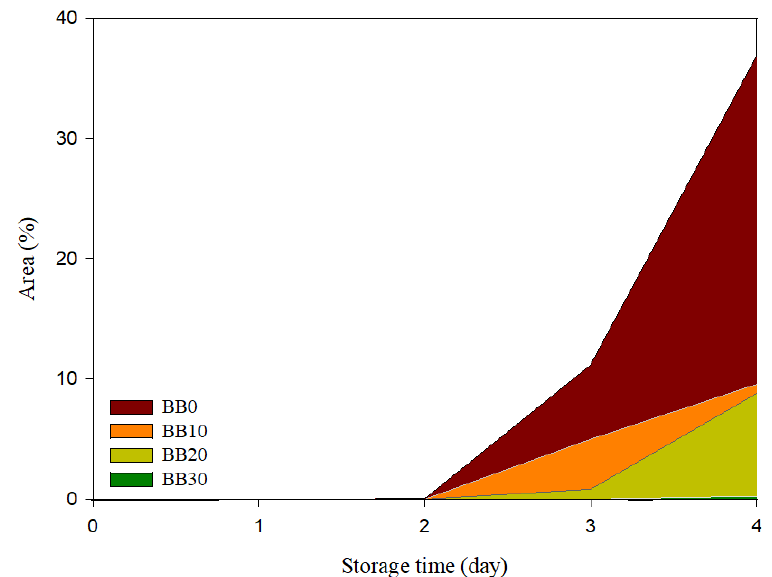
Figure 5. The mold growth area of black rice sourdough bread with different proportions of black rice sourdough powder was added. BB0: without black rice sourdough powder; BB10: with 10% black rice sourdough powder; BB20: with 20% black rice sourdough powder; and BB30: with 30% black rice sourdough powder.